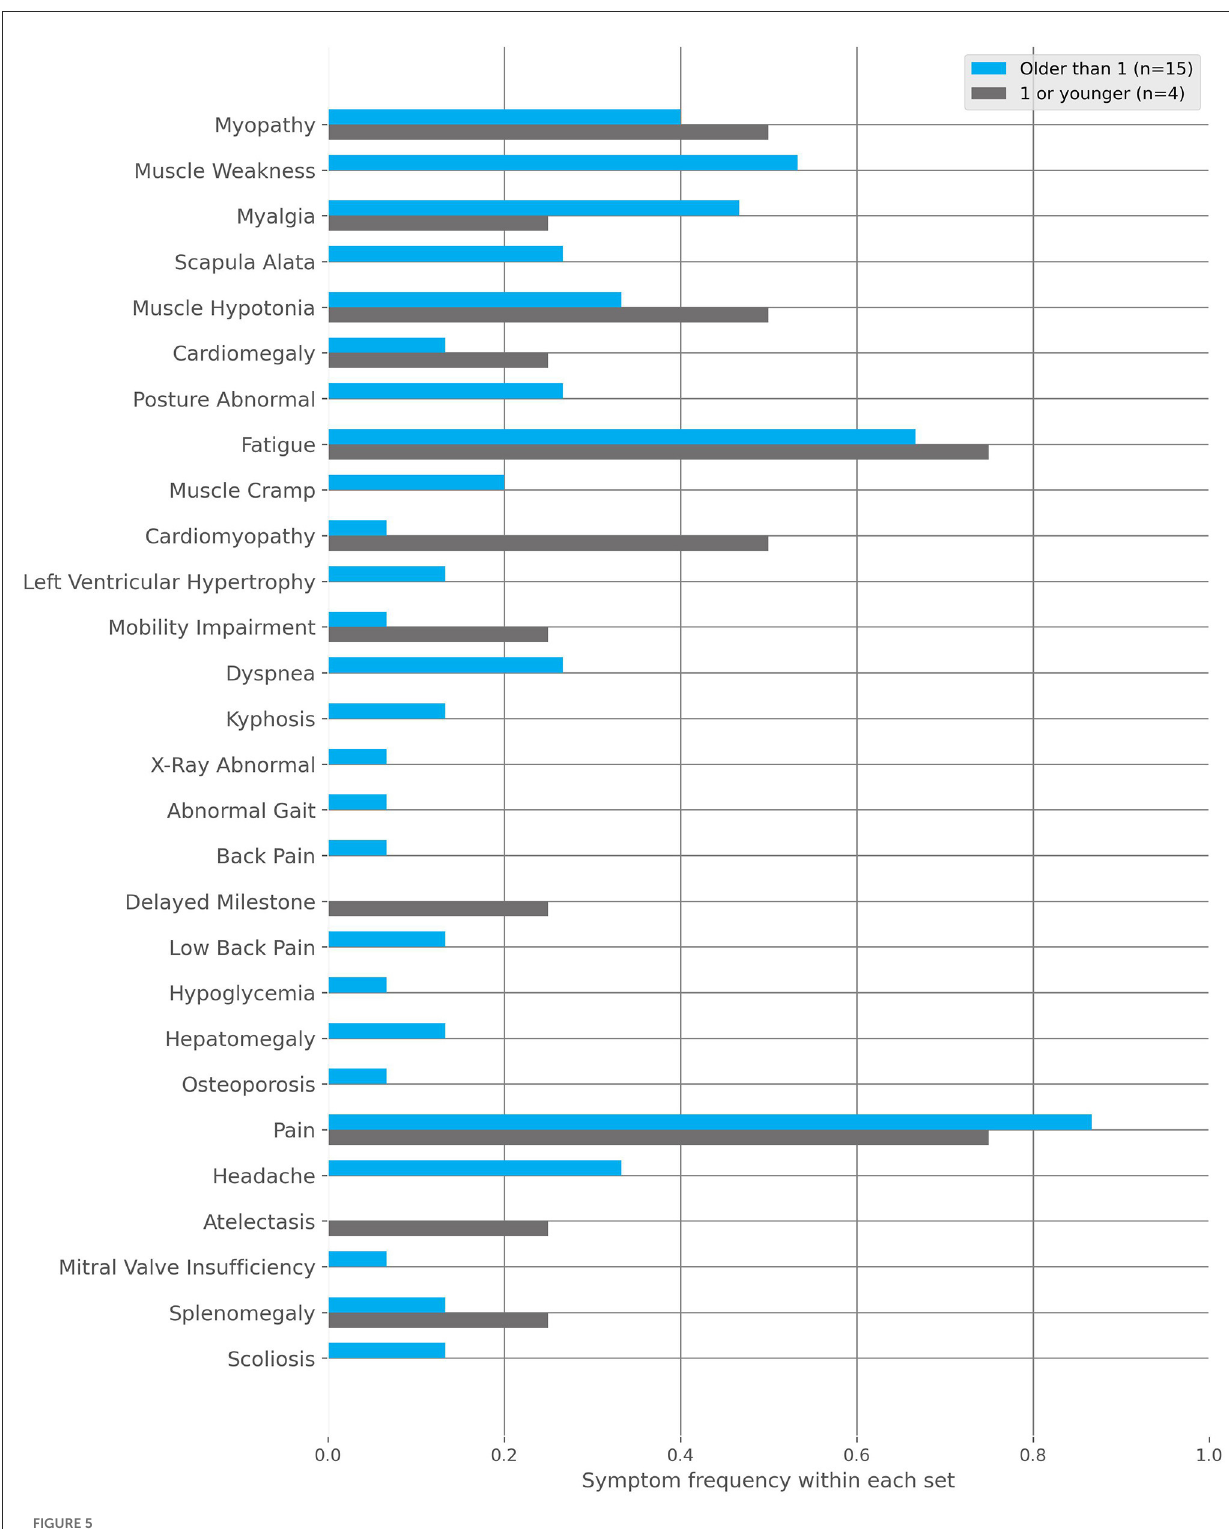
screening took < 1 month and resulted in 21 eligible patients per clinic. From this cohort, we found it required 5.47 patients to be manually reviewed to find one suspected